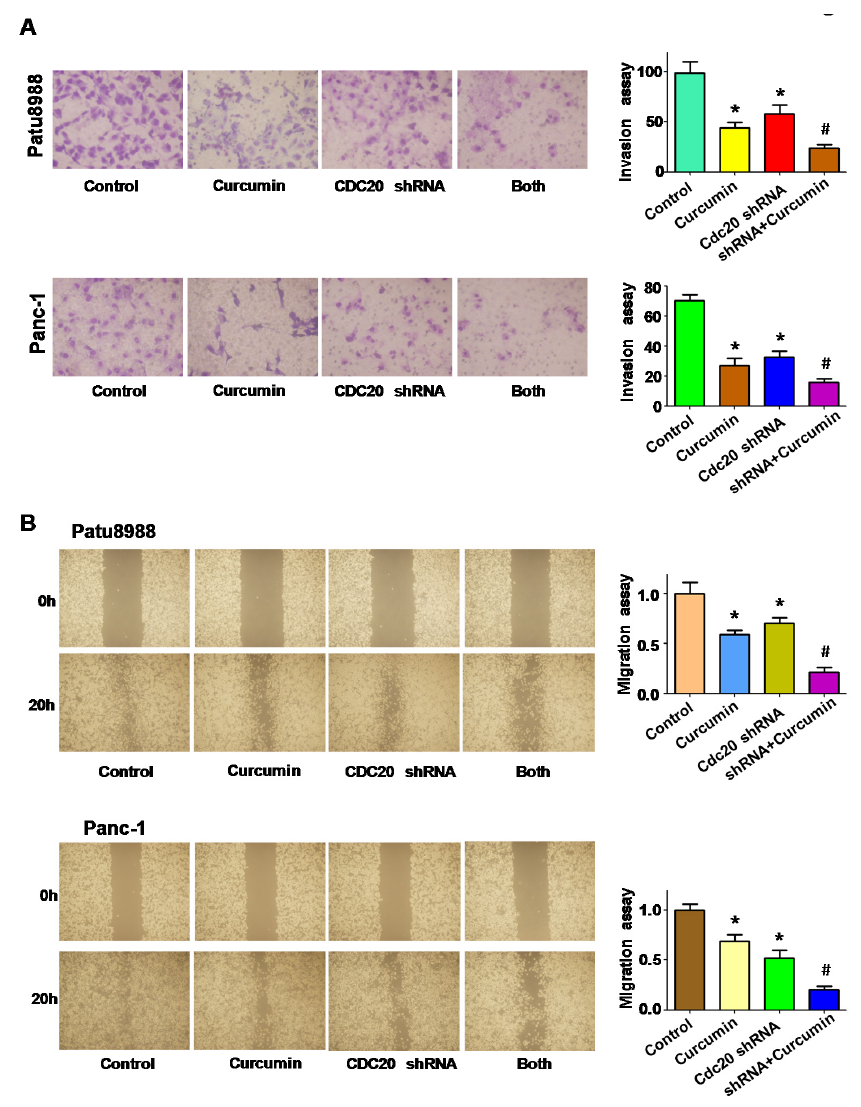
Figure 6. The effect of Cdc20 downregulation on cell migration, and invasion. ( A ) Invasion assay was conducted in PC cells after Cdc20 shRNA transfection and curcumin treatment; ( B ) The wound healing assay was used to measure the cell migration in PC cells after Cdc20 shRNA transfection and curcumin treatment. Both: curcumin + Cdc20 shRNA. * p < 0.05, vs. control; # p < 0.05 vs. curcumin treatment or Cdc20 shRNA transfection.